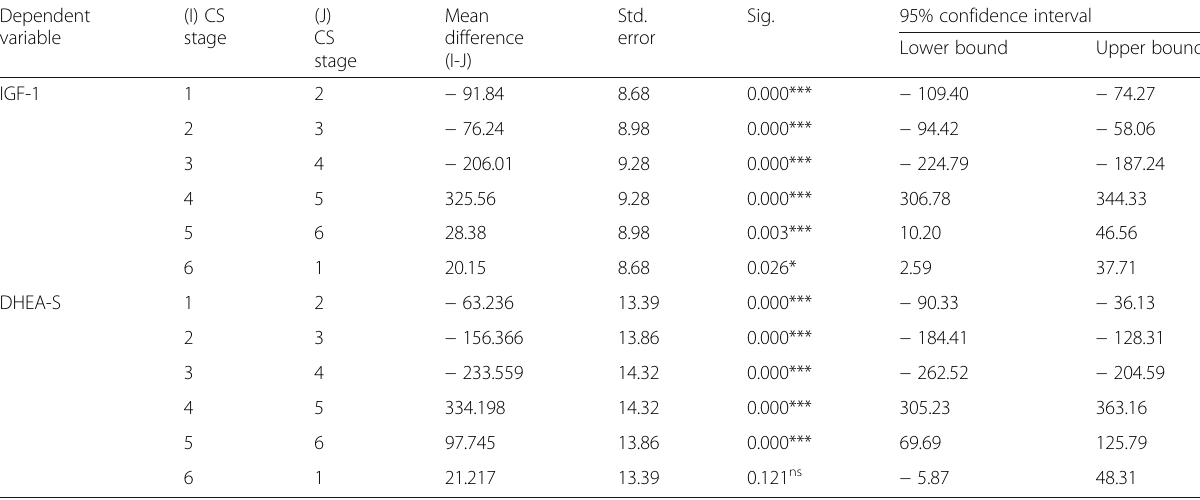
Table 3 Comparison of IGF-1 and DHEA-S levels in between the CS stages using the LSD test in group A Dependent